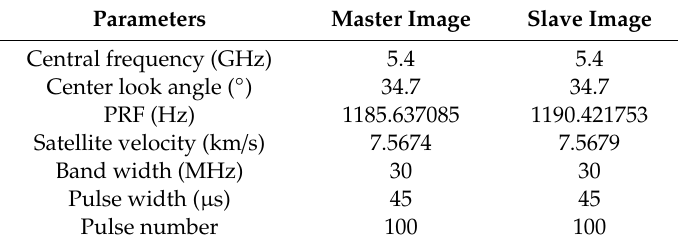
Table 1. Main parameters of the Gaofen-3 interferometric images. PRF: pulse repetition